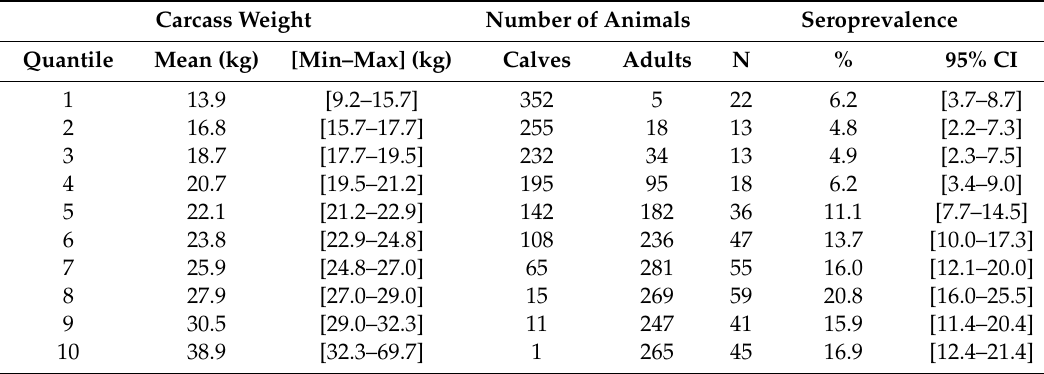
Table 2. Distribution of seroprevalence in 10 carcass weight quantiles and classification of